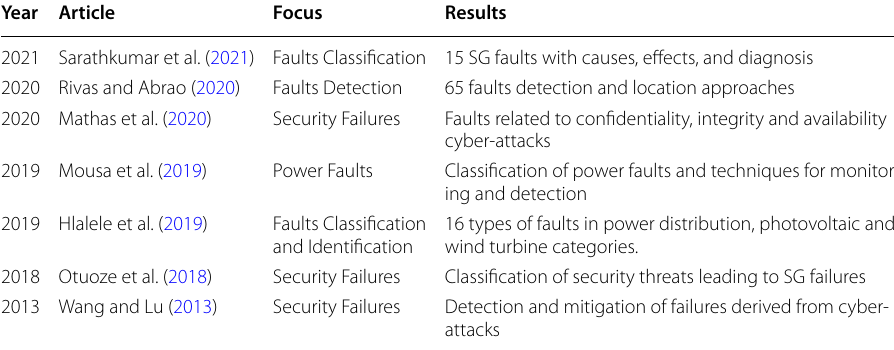
Table 1 Related works Year Article Focus